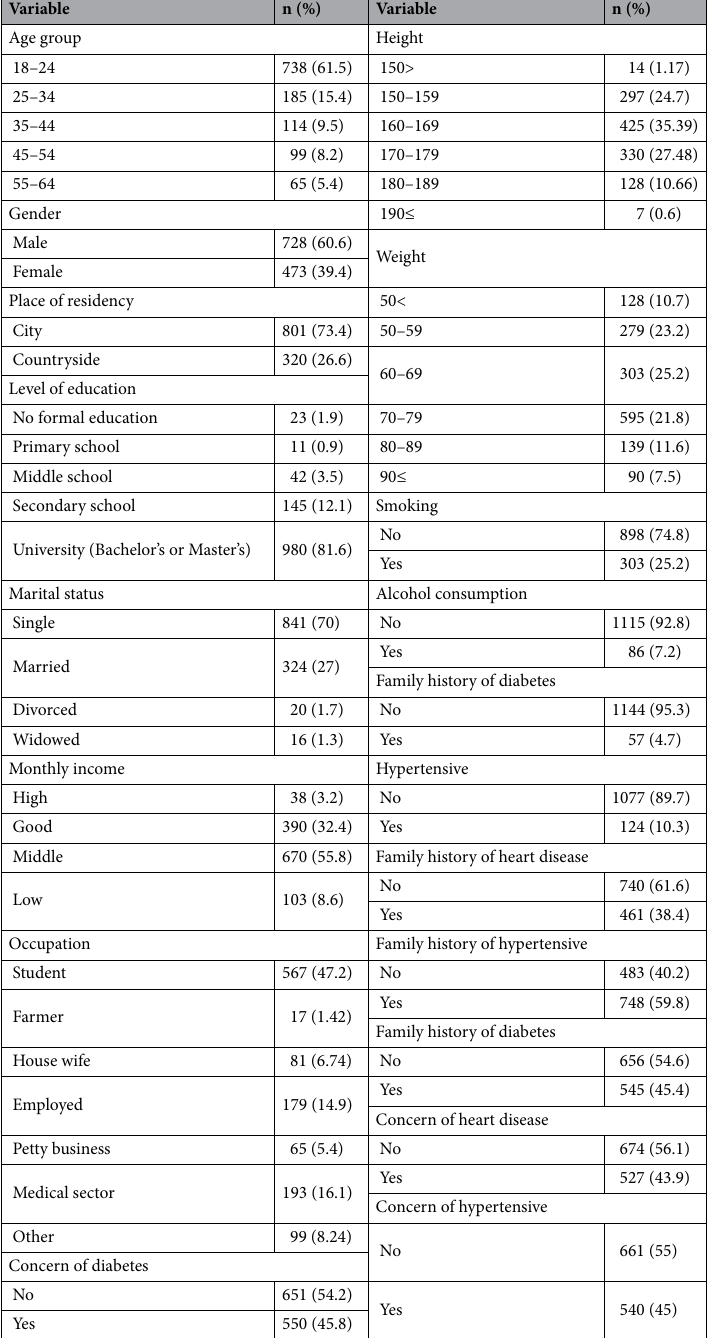
Table 1. Demographic characteristics of study